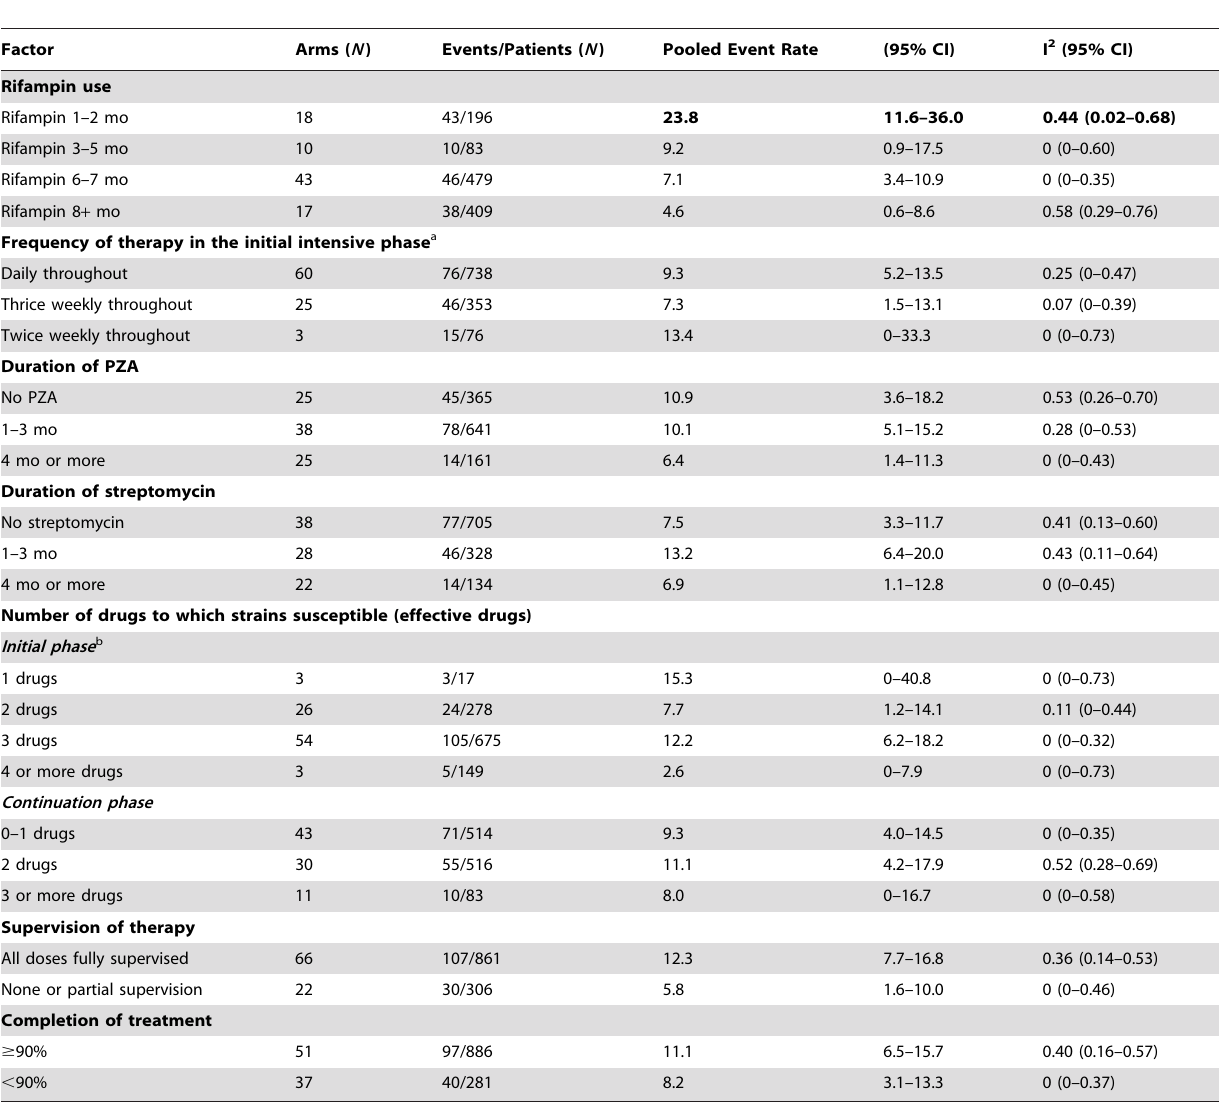
Table 4. Stratified analysis of covariates associated with TB treatment outcomes in RCT of patients with INH resistance in new or previously treated cases: Relapse in isoniazid